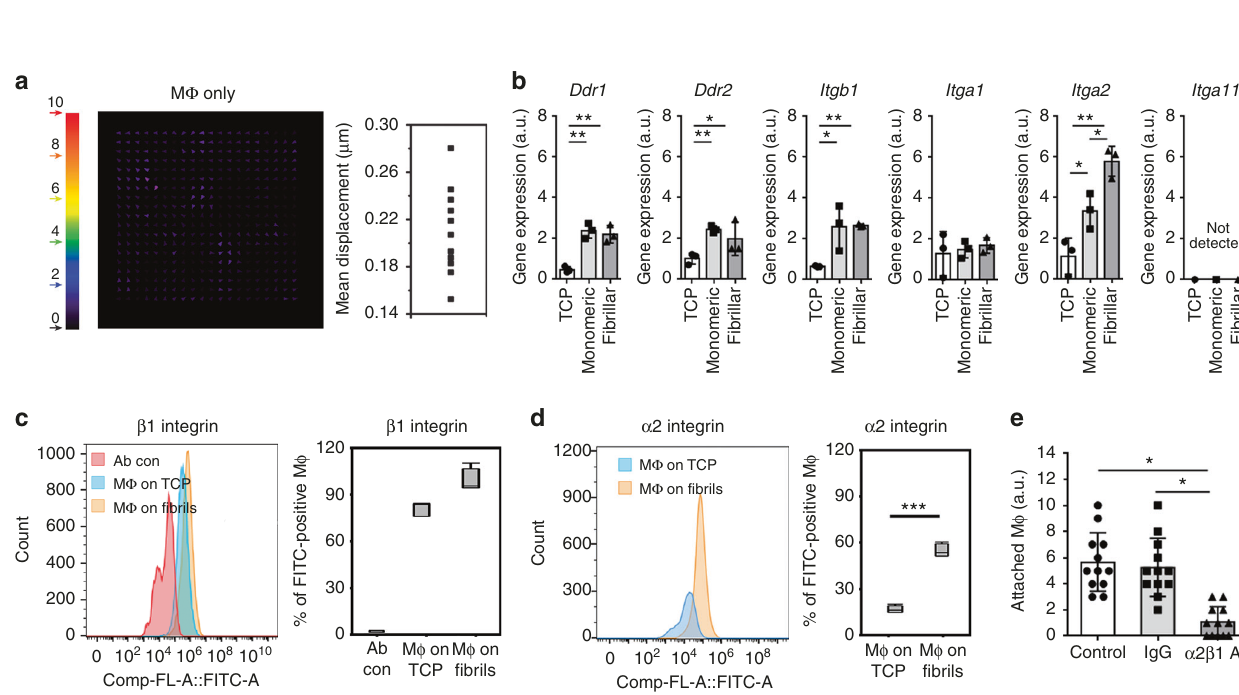
Fig. 7 Macrophage (M ϕ ) traction on fi brillar collagen extracellular matrix. a Marker displacements were used to calculate M ϕ -induced deformation fi elds using particle image velocimetry, displayed as vectors with color-coded magnitudes and average vector magnitudes per M ϕ are summarized in a graph (15 M ϕ , 11 independent experiments). b Quantitative reverse transcription polymerase chain reaction assessment of collagen I receptors in M ϕ grown for 7 days on uncoated tissue culture plastic (TCP) or TCP coated with monomeric and fi brillar collagen. Gene expression values were normalized to the average expression of house-keeping genes G6pd , Gapdh , and Hmbs ( N = 3). c , d For fl ow cytometry, primary mouse M ϕ were cultured on fi brillar collagen- coated surfaces for 6 h, detached, and live cells stained for c active β 1 integrin-detecting antibody (CD29, clone 9EG7), and d α 2 β 1 integrin (CD49b) fl uorescein isothiocyanate-coupled antibody followed by secondary fl uorescent antibody. M ϕ were incubated with secondary antibody only for control. Percentages of β 1 and α 2 integrin-positive M ϕ are shown as medians (center lines) of box (25th to 75th percentiles) and whisker (minimum to maximum) plots ( N = 3). e Suspended M ϕ were seeded onto fi brillar collagen-coated substrates in the presence of α 2 β 1 integrin blocking or control antibodies and percentages of attached M ϕ were quanti fi ed after 1 h ( N = 3). Graphs show averages ± SD, (* p < 0.05, ** p ≤ 0.01, *** p < 0.001 using analysis of variance followed by post hoc Tukey ’ s multiple comparison